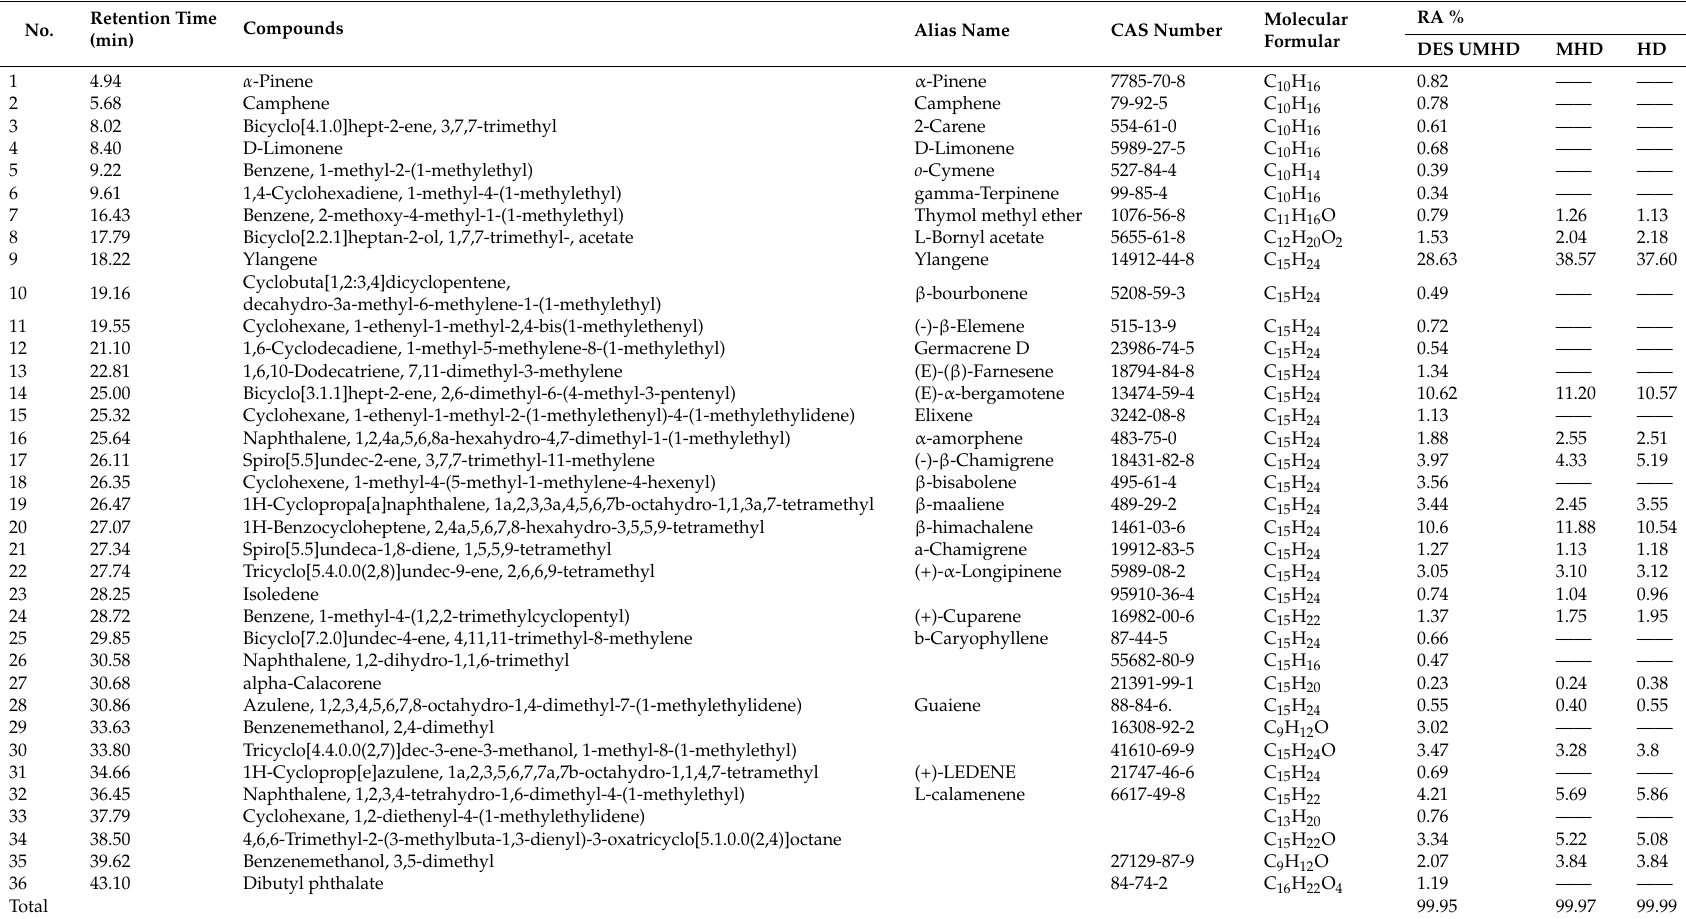
Table 6. Volatile compounds in S. chinensis essential oil obtained by HD, MHD and DES